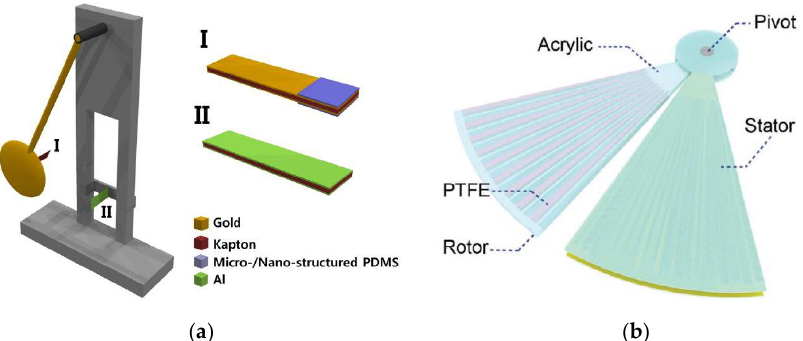
Figure 12. ( a ) Pendulum-driven triboelectric generator with micro–nano-structured PDMS [95]. Reprinted with permission from Ref. [95]. Copyright 2013, Elsevier. ( b ) Radial-grating pendulum- structured triboelectric nanogenerator [96]. Adapted with permission from Ref. [96]. Copyright 2018, WILEY-VCH Verlag GmbH & Co.